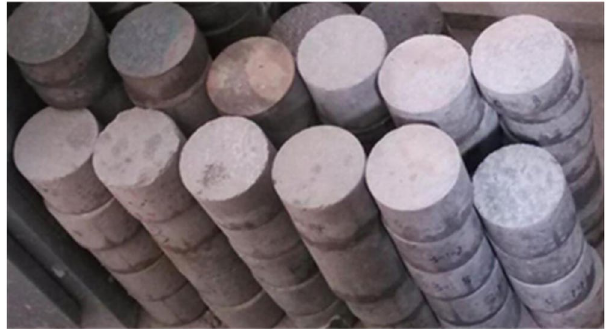
Figure 1. Photograph of the prepared BD specimens.